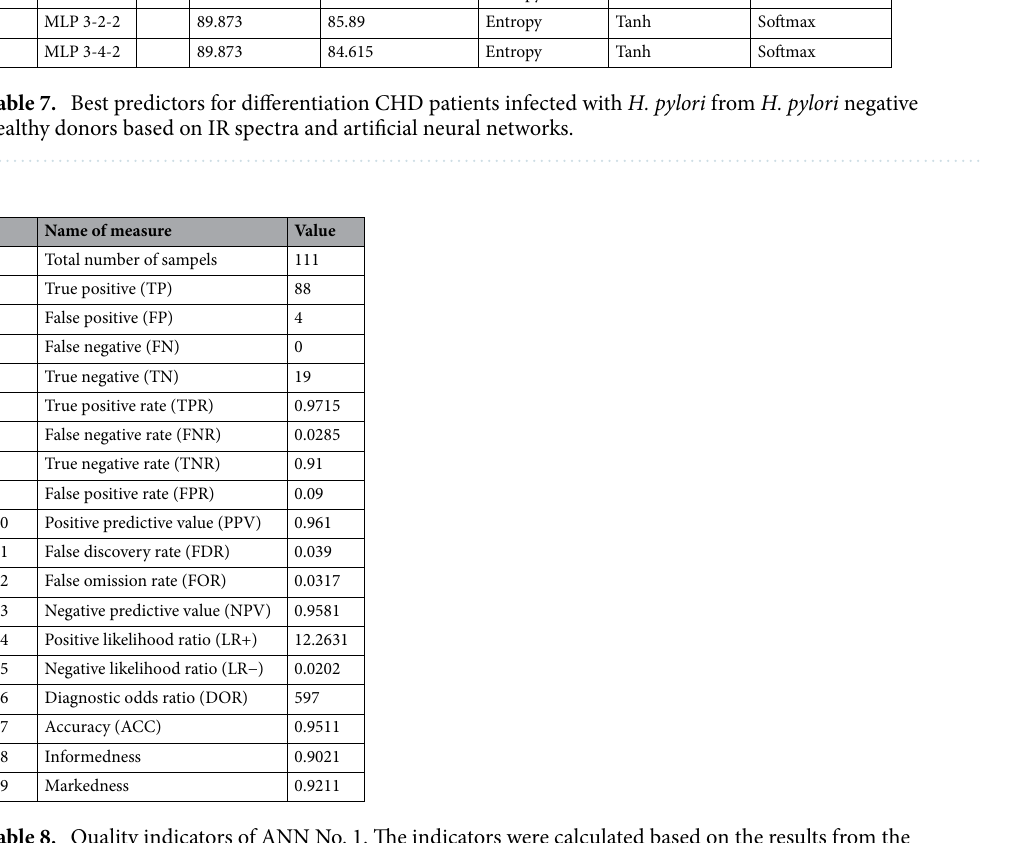
Table 8. Quality indicators of ANN No. 1. The indicators were calculated based on the results from the validation subset.